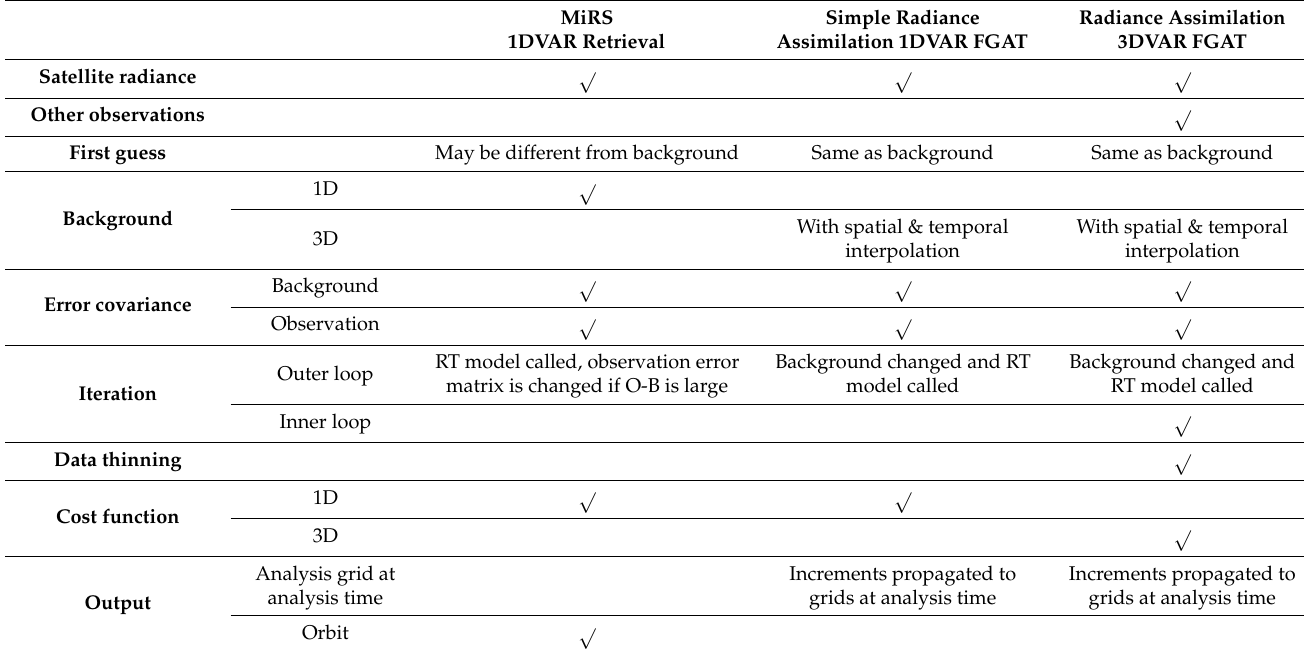
Table 1. Summary of 1DVAR retrieval, the simple radiance assimilation scheme used in this study, and operational radiance assimilation.